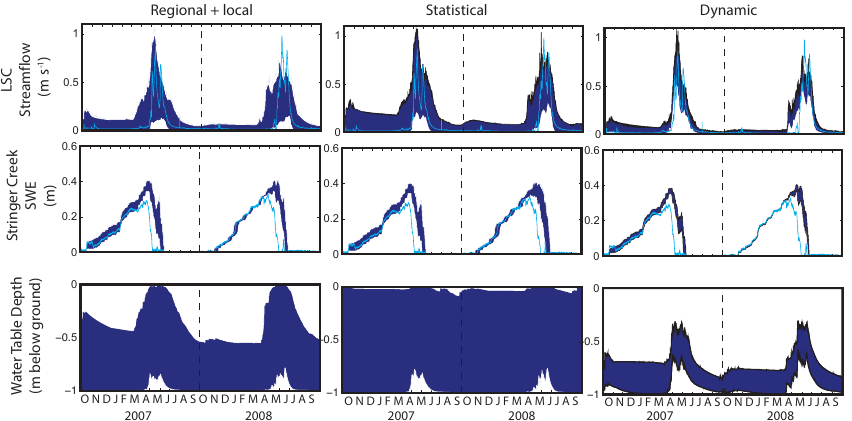
Figure 6. Ranges and distributions for predictions of streamflow, snow water equivalent (Stringer Creek SNOTEL site), and average water table depth for grouped constraints, which are outlined in Fig. 4. Predictions that meet a given set of constraints are shown as ranges in blue as a function of time. Results are shown for the calibration period (2008 WY) as well as a period of validation (2007 WY).